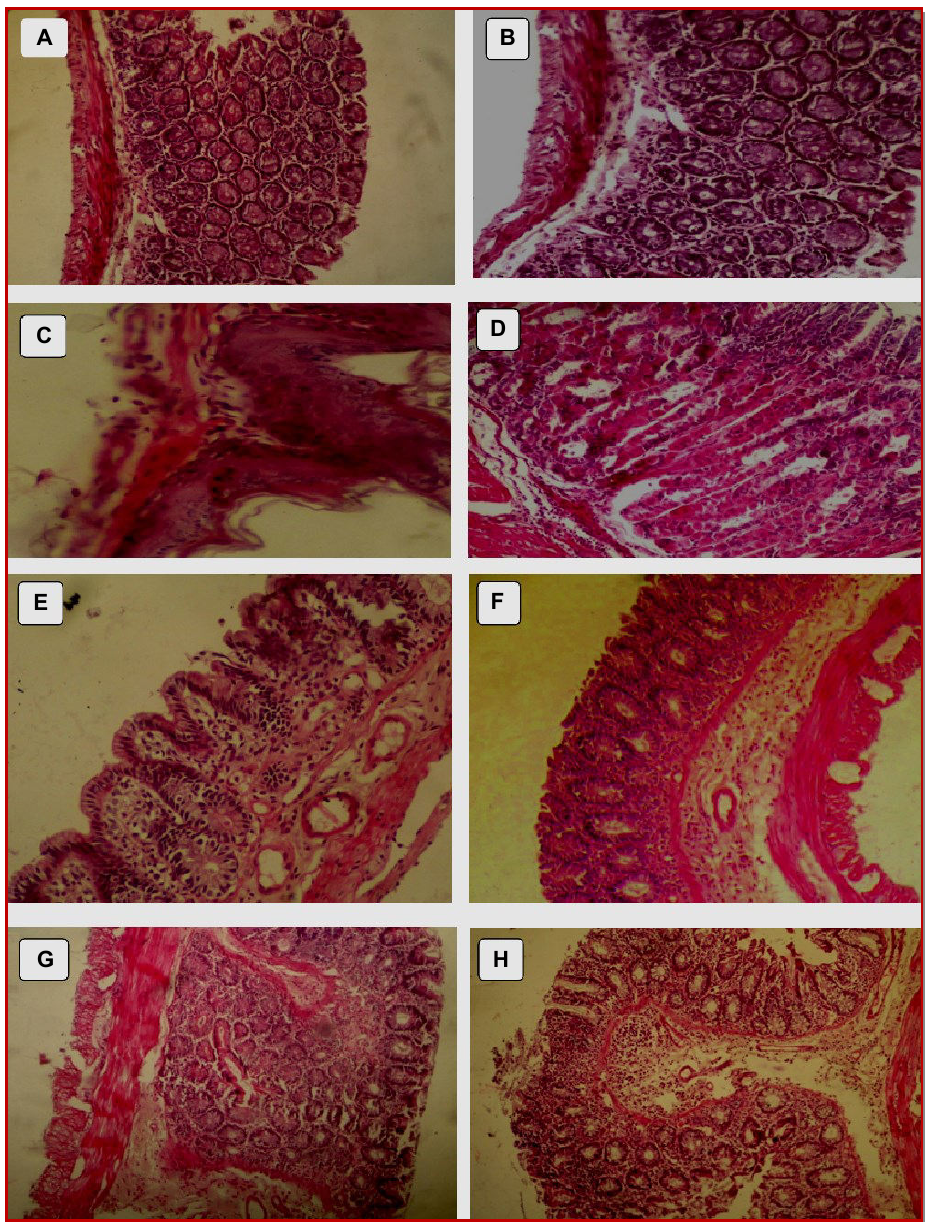
Figure 1: Histological examination of gastric mucosa of normal group (A); pretreated with the ranitidine 20 mg/kg (B); alcohol - induced ulcer (C); showing mucosal ulceration along with severe intramucosal hemorrhages; aspirin-induced ulcer (D); showing striking necrosis of gastric mucosa associated with hemorrhage; pretreated with ethanolic extract of 100 mg/kg of M. longifolia in alcohol-induced ulcer (E); showing mucosal congestion; pretreated with ethanolic extract of 200 mg/kg of M. longifolia (F); show- ing no histological changes in alcohol-induced ulcer; pretreated with ethanolic extract of 100 mg/kg of M. longifolia in aspirin- induced ulcer (G); congestion of submucosa associated with edema; pretreated with ethanolic extract of 200 mg/kg of M. longifolia (H); showing no histological changes in aspirin-induced